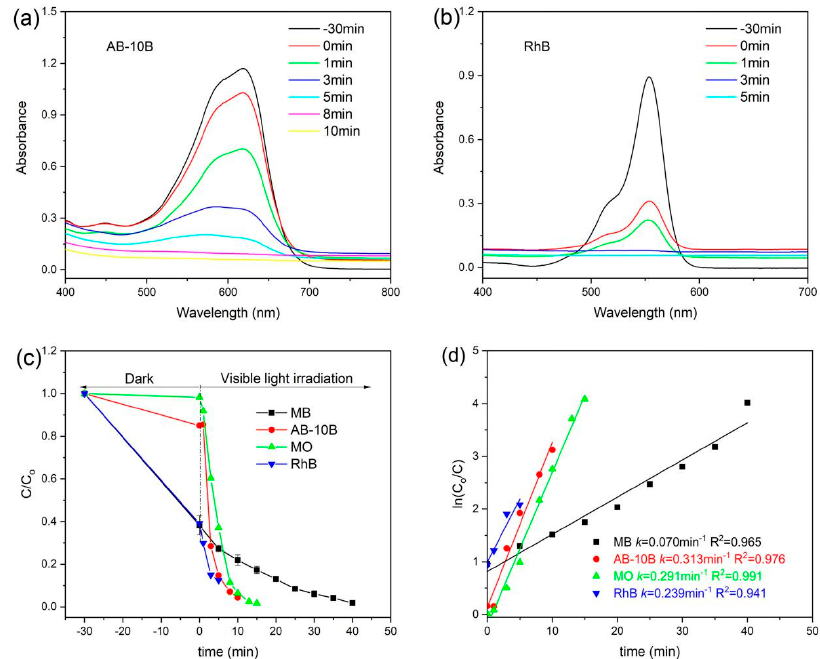
Figure 9. UV–vis absorption spectra of ( a ) AB-10B and ( b ) RhB dyes degradation by RGO/BiOCl/TiO 2 nanocomposites with 10% of TiO 2 under visible light irradiation (the nanocomposite concentration: 1.0 g/L); ( c ) photodegradation efficiency of different dyes over RGO/BiOCl/TiO 2 nanocomposites and ( d ) the corresponding fit curves obtained by pseudo-first-order kinetic model.